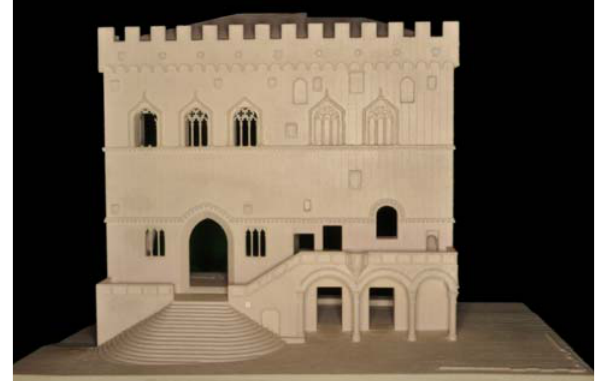
Figure 13. Solid model of the Palazzo dei Priori